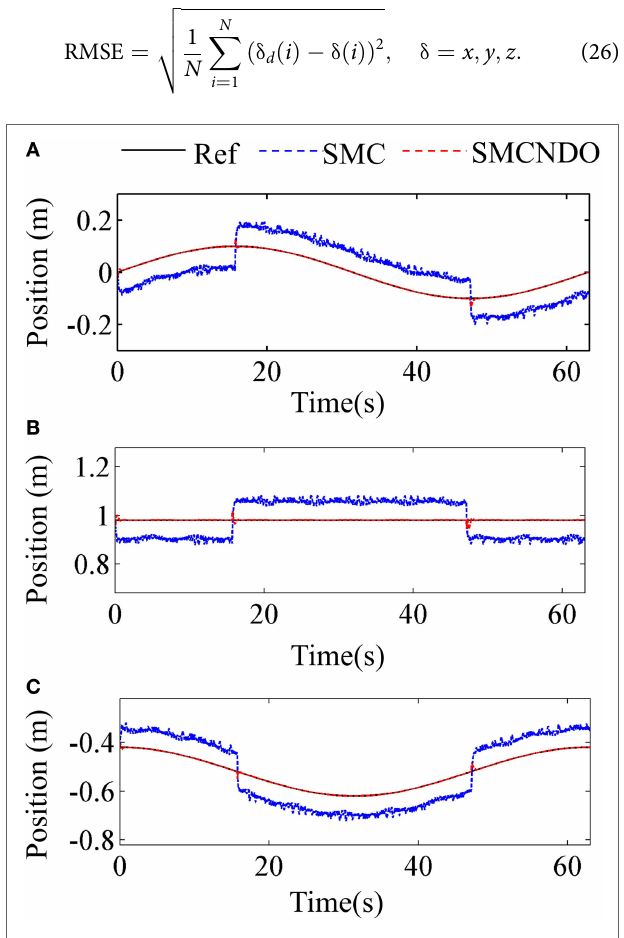
FIGURE 3 | Tracking performance in the three coordinate directions via sliding mode control (SMC) and sliding mode control with nonlinear disturbance p observer (SMCNDO). (A) Tracking performance in X direction, (B) tracking 2 m, and performance in Y direction, and (C) tracking performance in Z